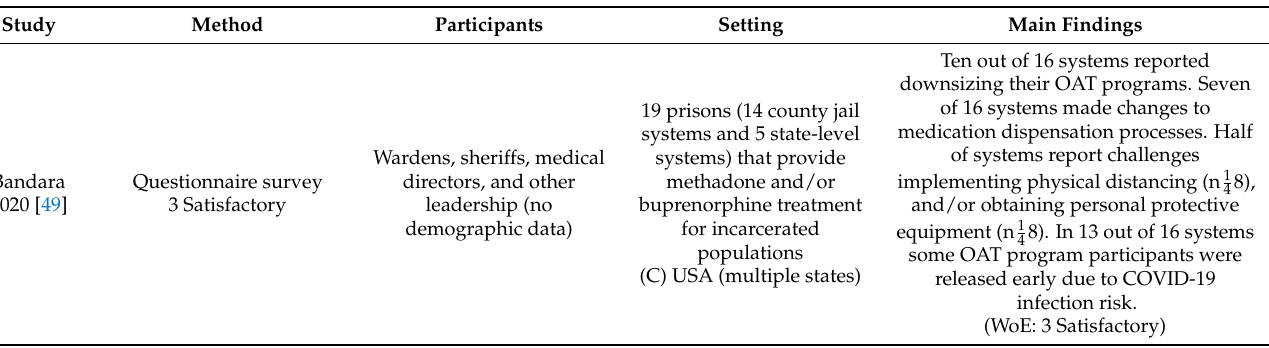
Table 11. Prison